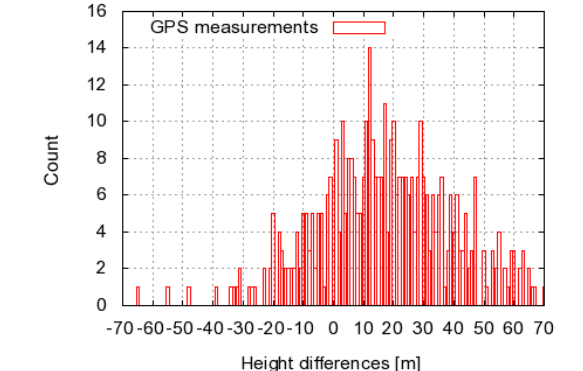
Figure 9. Comparison of heights between ground-based GPS measurements and ASTER GDEM-2 (legend is the same as that in Figure 5).